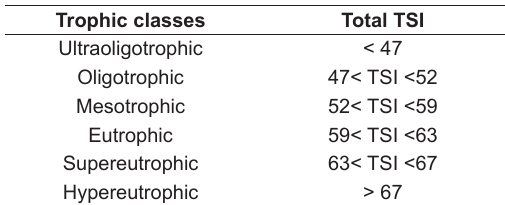
Table 1. Limits of the TSI and trophic classes (Lamparelli,